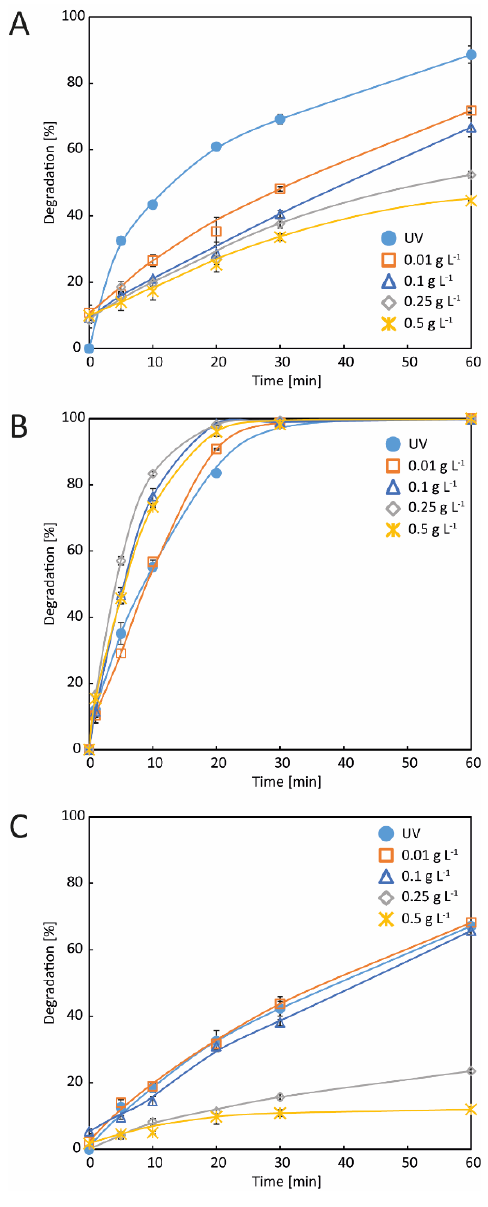
Figure 2. Removal of the tested compounds during photodegradation with ZnO. ( A ) Degradation of BPA, ( B ) degradation of BPS, ( C ) degradation of FLC. The initial concentrations of BPA, BPS, and FLC were 10 mg L −1 .